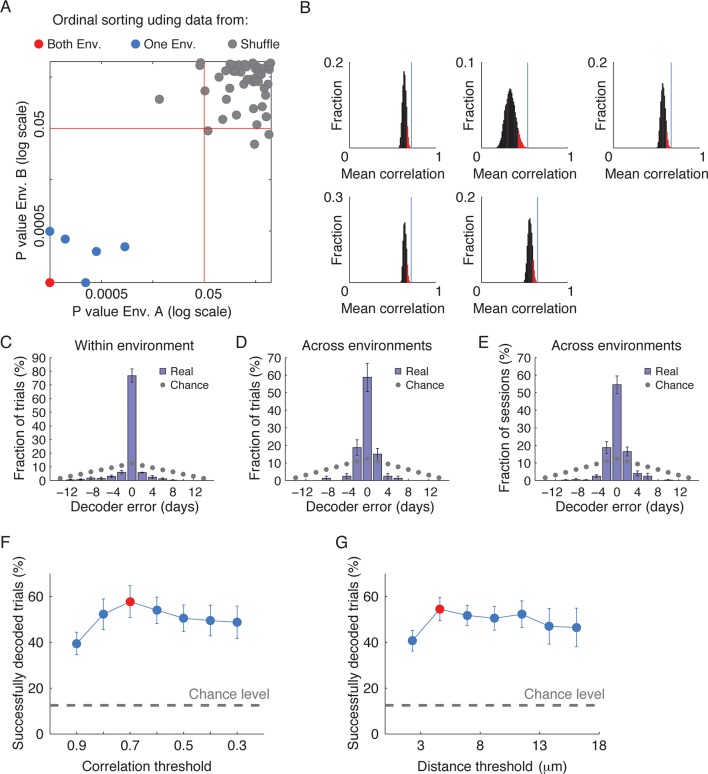
Time decoding is robust to changes in the across-session cell identification method.(A–D) We re-analyzed the data using the alternative, distance-based across-session cell identification routine, with a threshold distance of 5μm (See Figure 1—figure supplement 2). Using this alternatively analyzed data, we performed the same time decoding analyses shown in Figure 2D–H. (A) Performance of the ordinal time decoder. The red dots indicate perfect performance, as was achieved by using data from both environments together. Sorting of the sessions using data from one of the environments significantly outperformed sorting of the sessions using data in which the day labels of each cell’s activity patterns were randomly shuffled (gray dots, n =10 shuffles per mouse). (B) Distributions of the correlations between ensemble activity patterns averaged over the seven pairs of neighboring days for all 8!/2 possible day permutations. Vertical lines indicate the mean correlations between activity patterns of pairs of neighboring days of the actual data. As in the analysis shown in Figure 2C and Figure 2—figure supplement 2A, we found that in all mice, actual data yielded the highest mean correlation of all possible permutations. (C) A ‘within-environment time decoder’ was trained and tested on data from the same environment. Shown are distributions of the decoder’s errors in inferring the day from which a test data (single trials) was taken. The decoder successfully inferred the days from which the test data was taken in the majority of cases. (D,E) An ‘across-environment time decoder’ was trained on data from one environment (A or B) and tested on data from the other environment (B or A, respectively). Shown are distributions of the decoder’s errors in inferring the day from which a test data consisting of single sessions (D) or single trials (E) were taken. The decoder successfully inferred the day from which the test data was taken in the majority of cases. (F, G) Changing the threshold for a candidate cell to register as the same neuron across sessions did not alter the conclusions regarding the performance of the across environment time decoder. (F) The success rates of the time decoder changed only slightly and were highly significant in comparison to the chance level over a broad range of thresholds used by the correlation-based across-session cell identification routine (z-test, p < 10-8 for all comparisons). The red data point indicates optimal threshold, consistent with an independent analysis shown in Figure 1—figure supplement 2C. (G) The success rates of the time decoder changed only slightly and were highly significant in comparison to the chance level over a broad range of thresholds used by the distance-based across-session cell identification routine (z-test, p < 10-8 for all comparisons). The red data point indicates optimal threshold, consistent with an independent analysis shown in Figure 1—figure supplement 2D. Data are mean ± s.e.m.